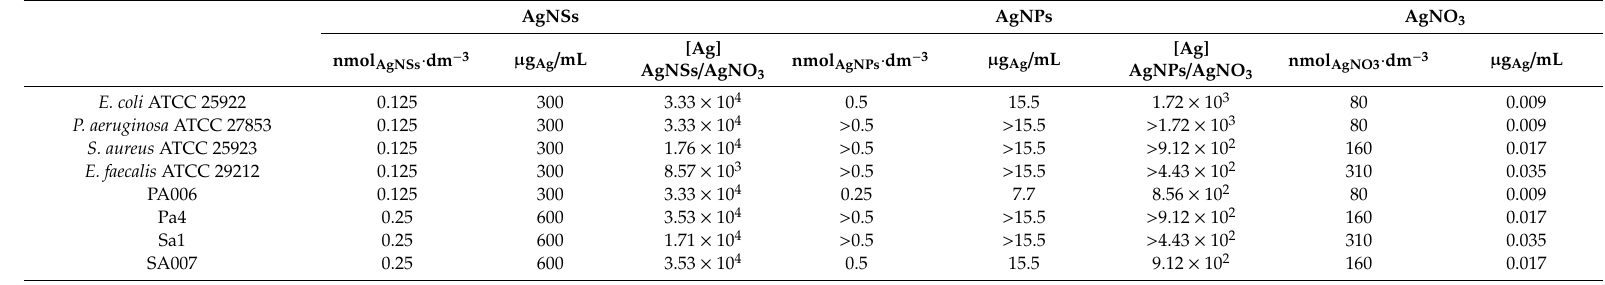
Table 2. MIC values of AgNSs, AgNPs and AgNO 3 in TSB medium against several strains, including multidrug-resistant isolates of P. aeruginosa (PA006 and Pa4) and of S. aureus (Sa1 and